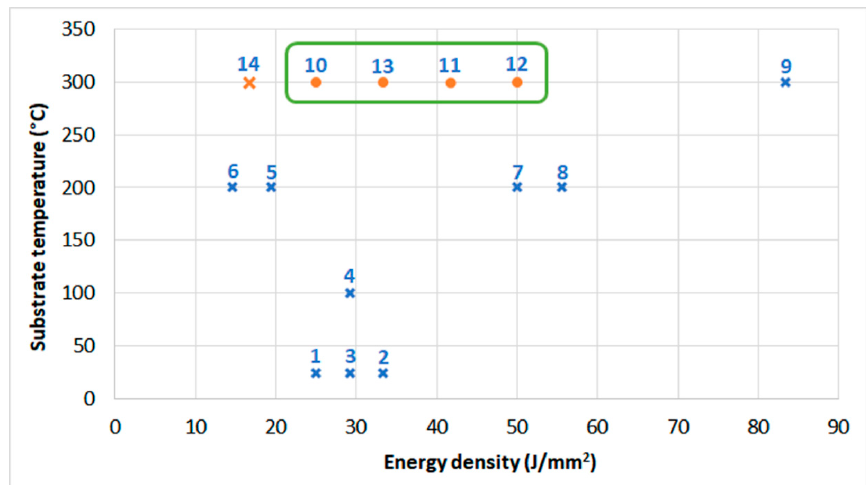
Figure 4. Plot of dependence between substrate temperature and energy density (for samples 1–9, the energy density was calculated using the laser power employed in the depositing process—marked in blue. For samples 10–14, the energy density was calculated using the laser power employed for the substrate heating—marked in orange). The X marks indicate samples with cracks.